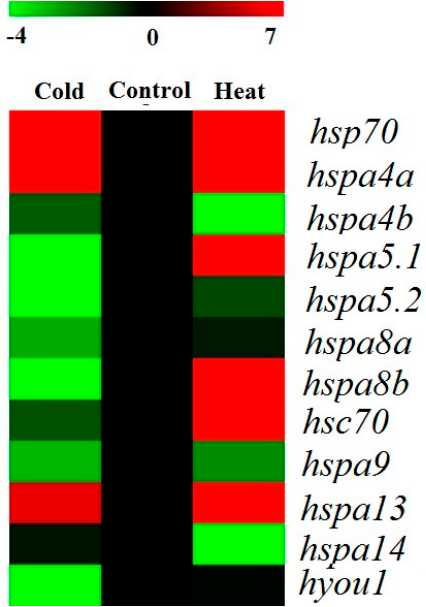
Figure 4. The hsp70 expression of the large yellow croaker based on reads per kilobase per million mapped reads (RPKM) values.